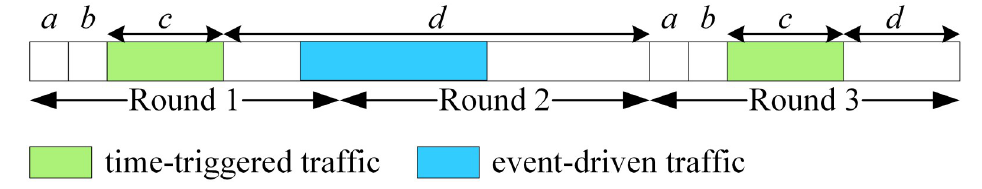
Fig 7. Periodical structure of TD-IMOCRP for cross-round event-driven data